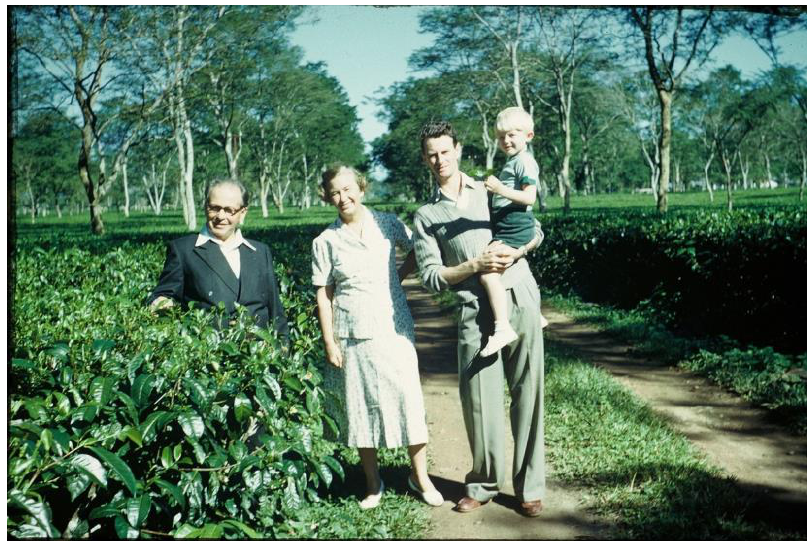
Figure 7. Dr. J.M.G. Wilson, 7th from the left back row and Prof Höjer, 3rd from left front row, at a meeting of the Assam branch of the British Medical Association in Panitola, Dribrugarh.